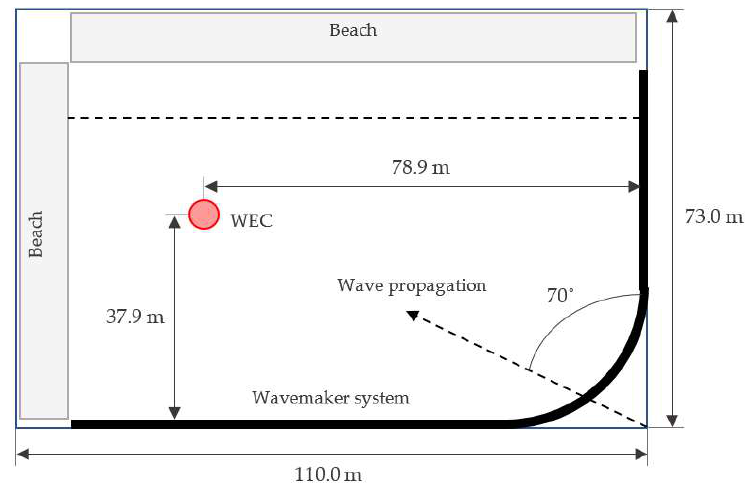
Figure 2. Top view diagram of Maneuvering and Sea Keeping (MASK) basin with WEC location.